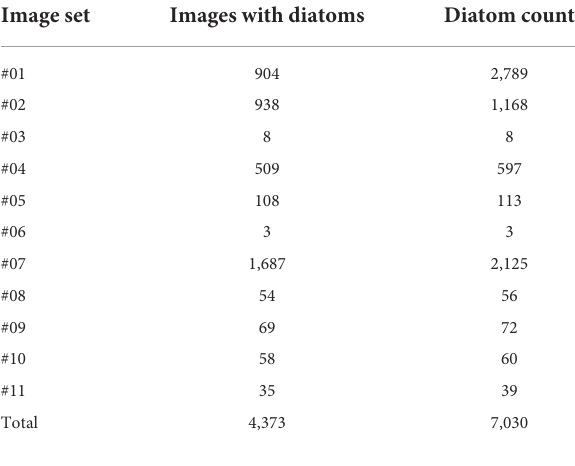
TABLE 2 Summary of the SEM images scanned from the liver and kidney samples. Image set Images with